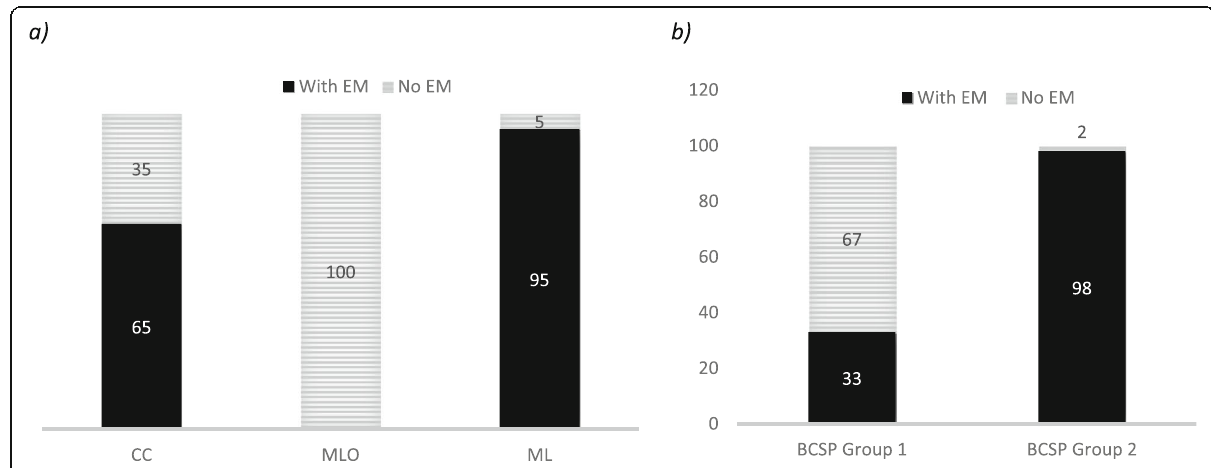
Fig. 2 Eklund Man œ uvre (EM): a percentage of exams (CC, craniocaudal; MLO, mediolateral oblique; and ML, mediolateral images) acquired with and without Eklund (EM); b EM according to each Regional Breast Cancer Screening Program (BCSP): Geneva (GVA) and Vaud (VD) for CC view